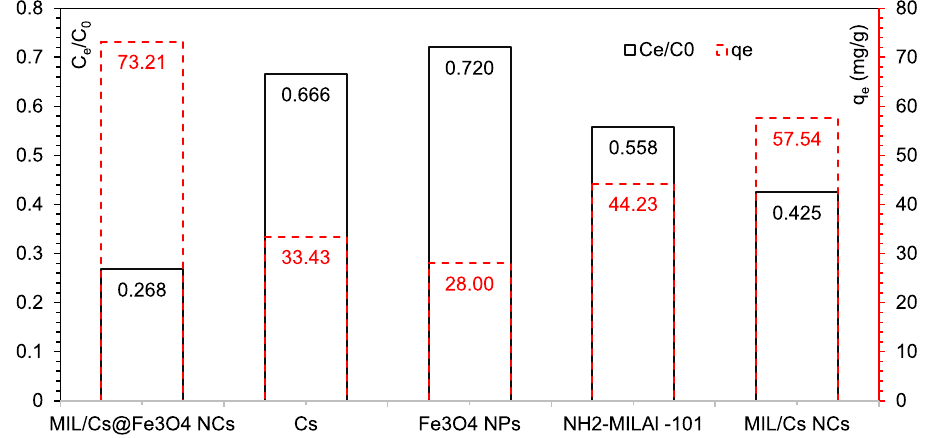
Figure 2. Comparison of AZT removal with different adsorbents under same